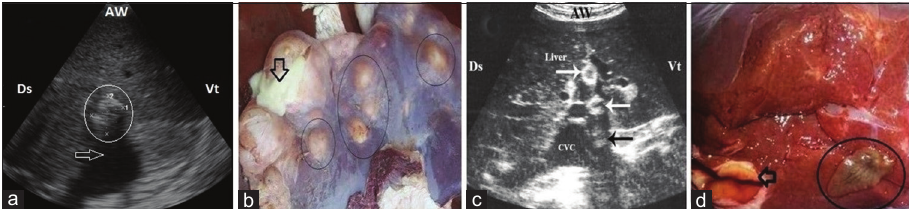
Figure-2: (a) Ultrasonography (US) of liver at the right 8 th ICS with a three microconvex transducer shows hyperechogenic structure (circle) with distal acoustic shadowing (arrow). This represents a calcified abscess. (b) Necropsy of a piece of liver shows multiple abscesses (circles) exit pus in cross section (arrow). (c) US of the liver at the level of the right 9 th ICS with a convex transducer shows multifocal echogenic patches with ring appearance of bile ducts (white arrow) and distal acoustic shadowing (black arrow). (d) Necropsy of a piece of liver shows adult Fasciola (circle) with calcified bile duct (arrow). AW=Abdominal wall, Ds=Dorsal, Vt=Ventral.